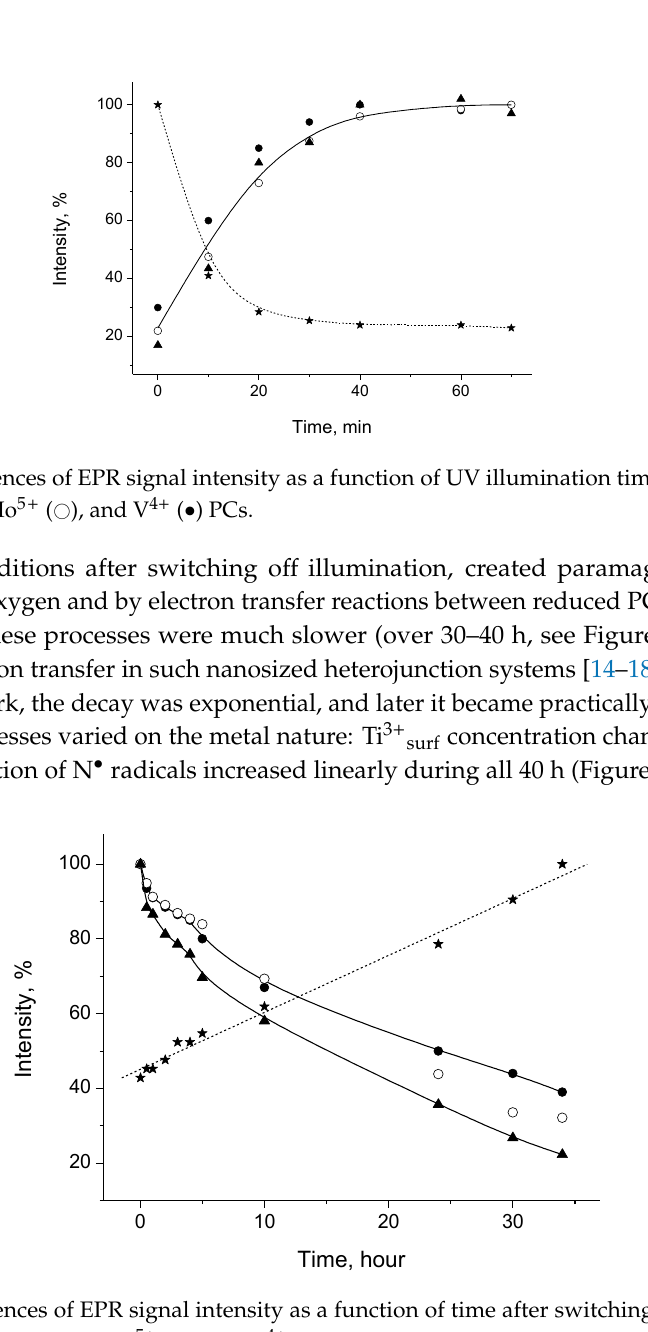
Figure 8. Dependences of EPR signal intensity as a function of time after switching off UV light for Ti 3+surf ( ▲ ), N • radical ( star ), Mo 5+ ( ○ ), and V 4+ (●) PCs.